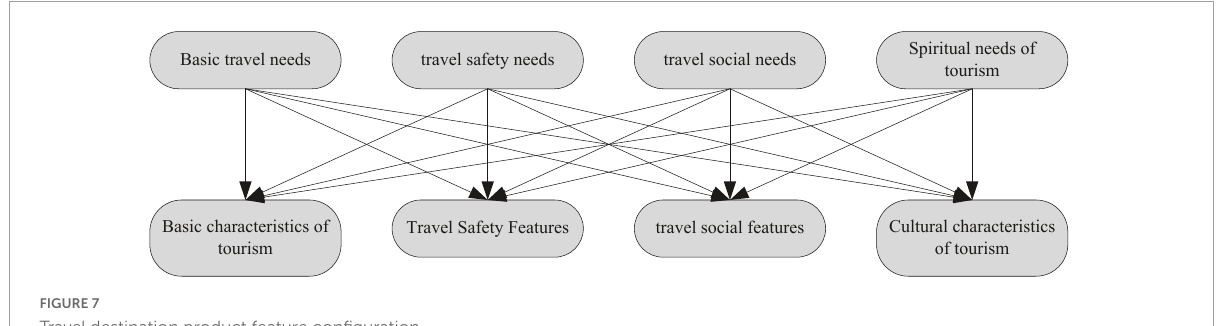
FIGURE7 Travel destination product feature